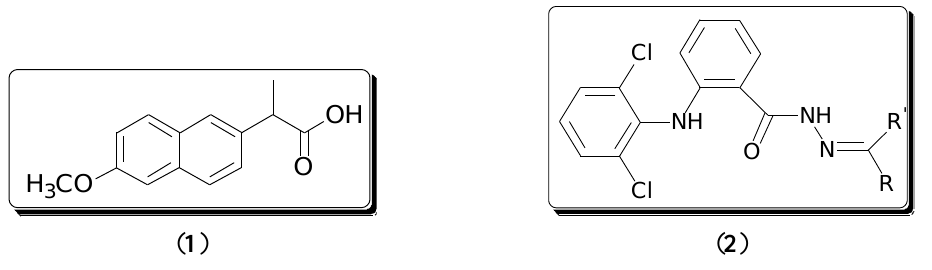
Figure 1. Naproxen and diclofenac acid hydrazide-derived